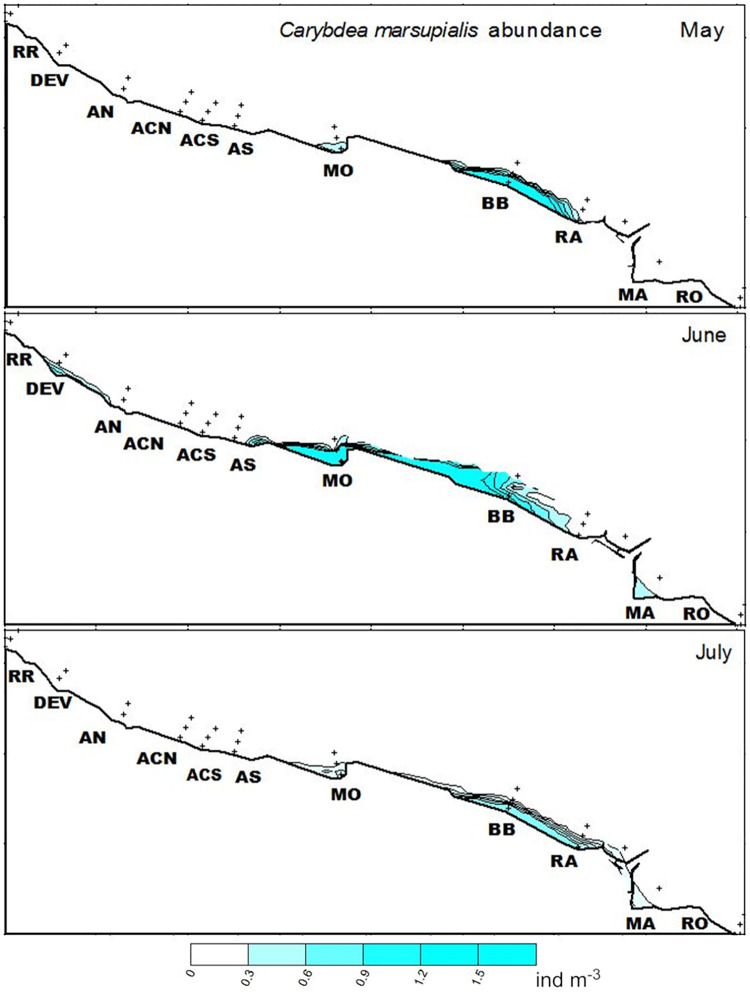
Spatio-temporal distribution of juvenile Carybdea marsupialis (ind m-3) at all sampling locations for May, June and July 2015.Station abbreviations as in Fig 1. Small crosses show sampling points. Source: own elaboration.